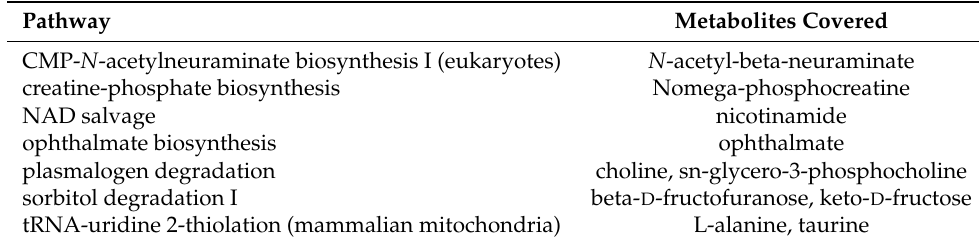
Table A9. ST000741, Pathway Covering Using Pathway Harmony Cost Function.